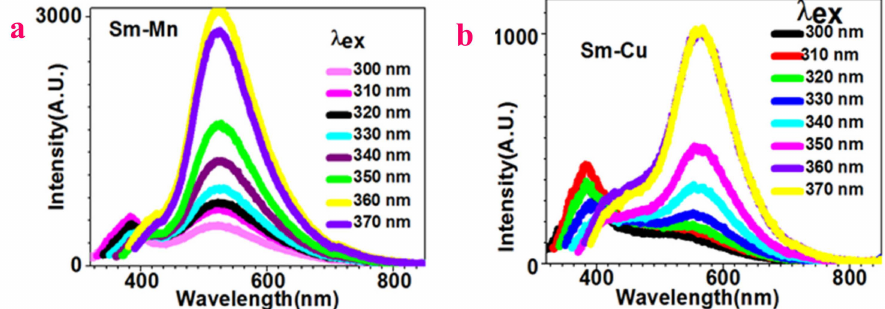
Figure 4. Sm–Mn and Sm–Cu compound nanoparticles show tunable white-to-green fluorescence by variation of excitation light around 300–400 nm: ( a ) Sm–Mn; ( b )